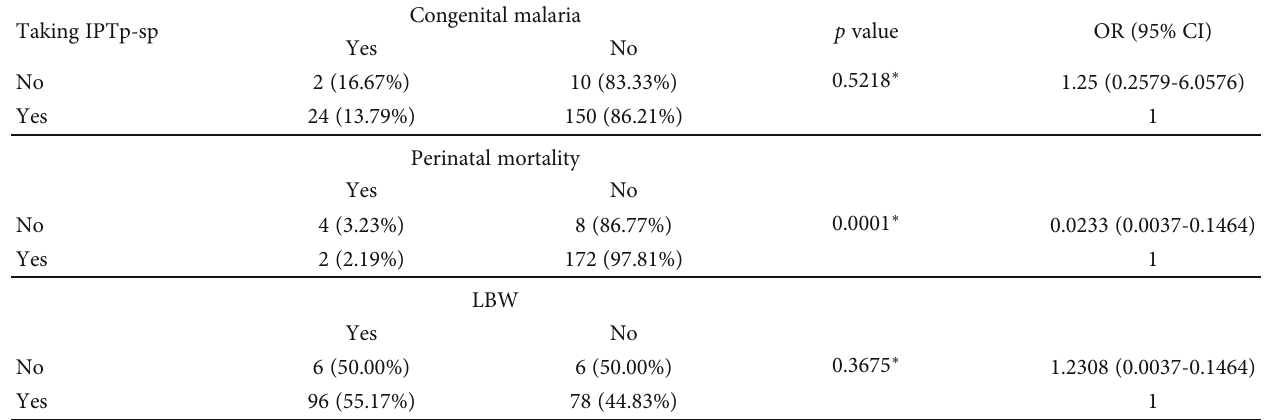
Table 4: Relationship between taking IPTp-sp and the outcome of pregnancy ( N = 186 ). Taking